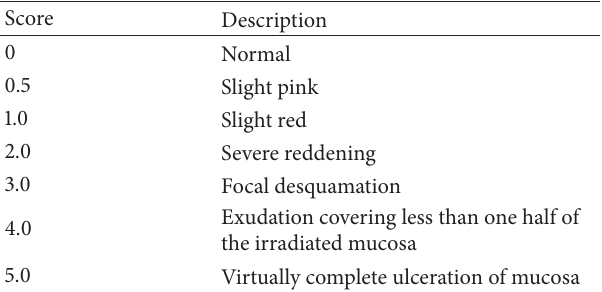
Table 1: Oral mucositis score (OMS) for busulfan plus radiation induced oral mucositis.